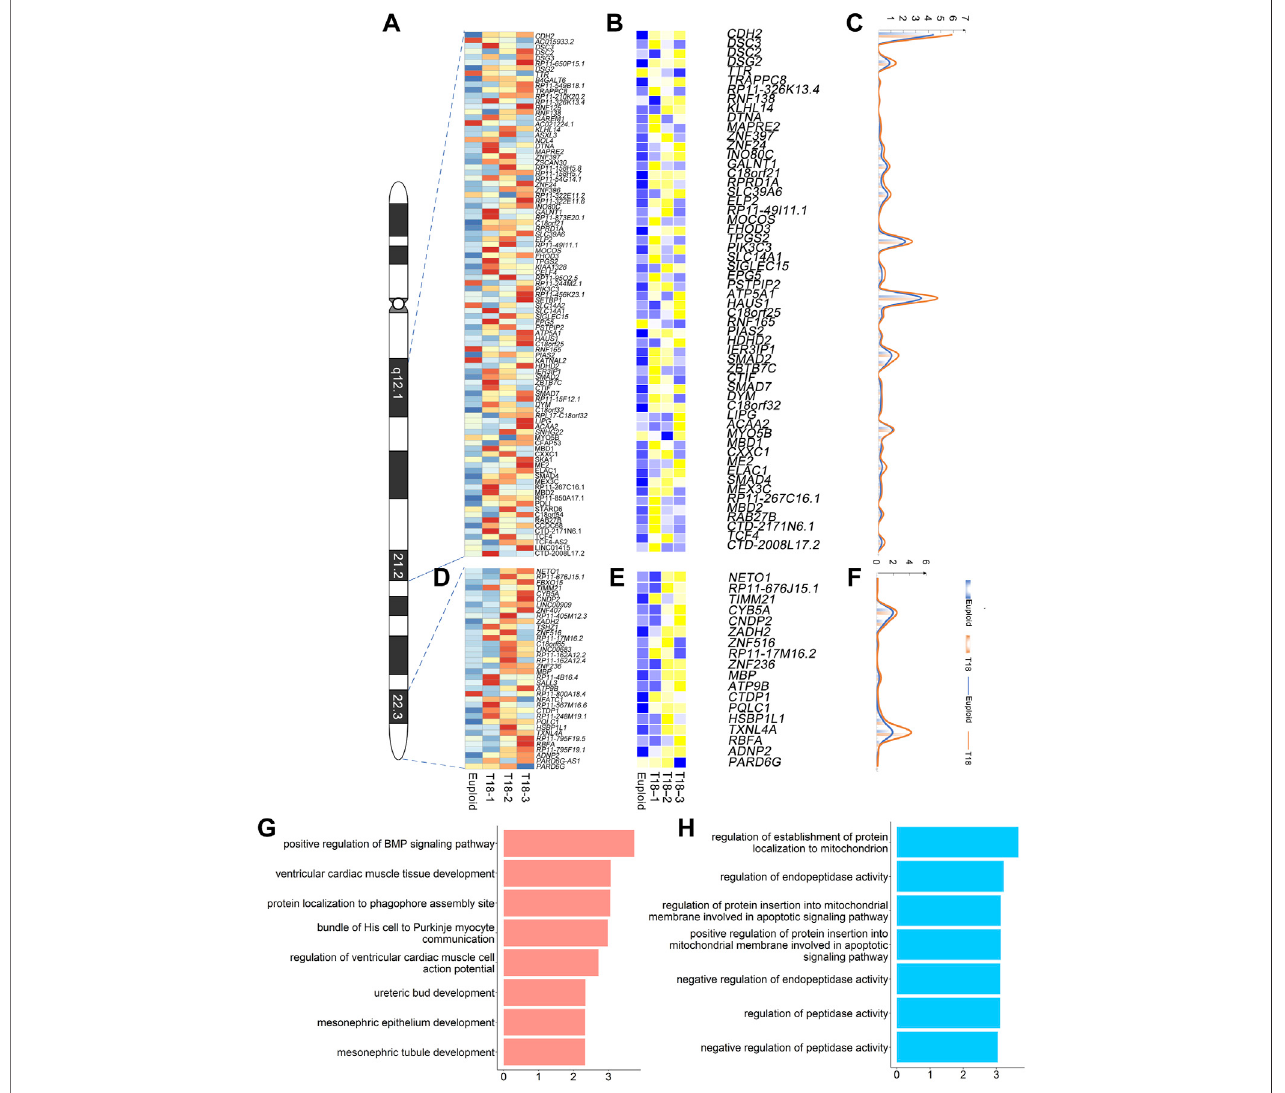
FIGURE 4 | Gene expression analyses in previously proposed trisomy 18 critical regions: 18q12.1-21.2 and 18q22.3-18qter. (A) Heatmap of expression levels of genes in the 18q12.1-21.2 region from two euploid and three trisomy 18 samples. (B) Heatmap of differentially expressed genes ( p ≤ 0.01) in the 18q12.1-21.2 region. (C) Unique molecular identi fi ers (UMIs) counts of differentially expressed genes in euploid (blue line) and trisomy 18 samples (orange line). (D) Heatmap of expression levels of genes in the 18q22.3-18qter region from two euploid and three trisomy 18 samples. (E) Heatmap of differentially expressed genes ( p ≤ 0.01) in the 18q22.3-18qter. (F) UMIs counts of differentially expressed genes in euploid (blue line) and trisomy 18 samples (orange line). (G) Top gene ontology (GO) terms of differentially expressed genes in the 18q12.1-21.2 region. (H) Top GO terms enriched for differentially expressed genes in the 18q22.1-18qter region.